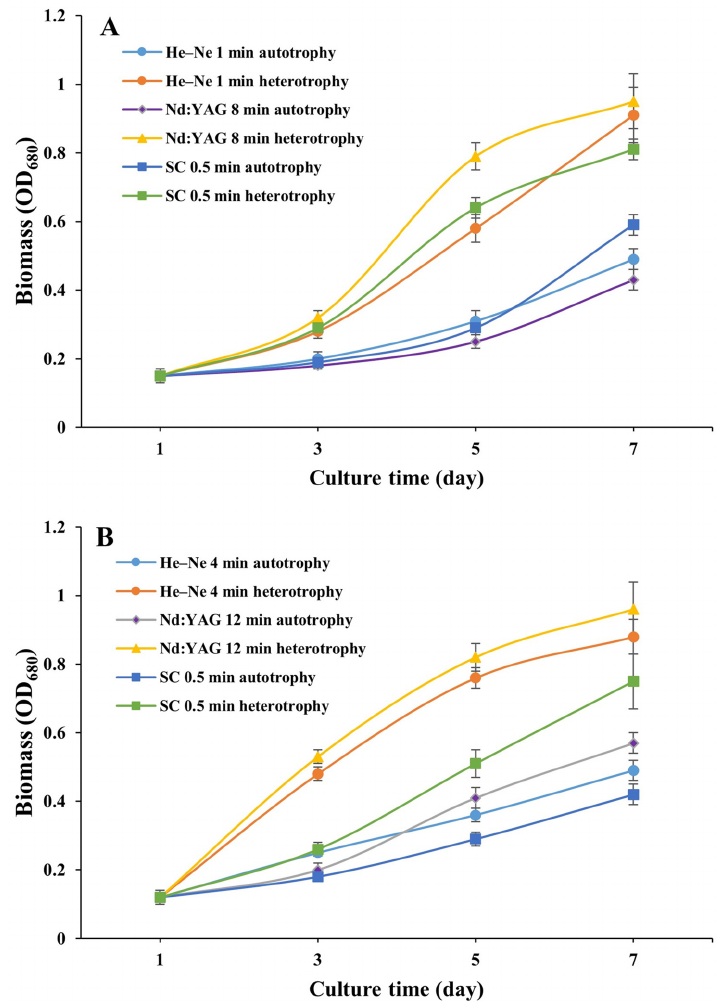
Figure 2. Figure 2. Growth curves of laser mutants of Chlorella vulgaris strain FACHB 9 ( A ) and C. pyrenoidesa strain FACHB 31 ( B ) cultured under autotrophic and heterotrophic conditions for 7 days (one